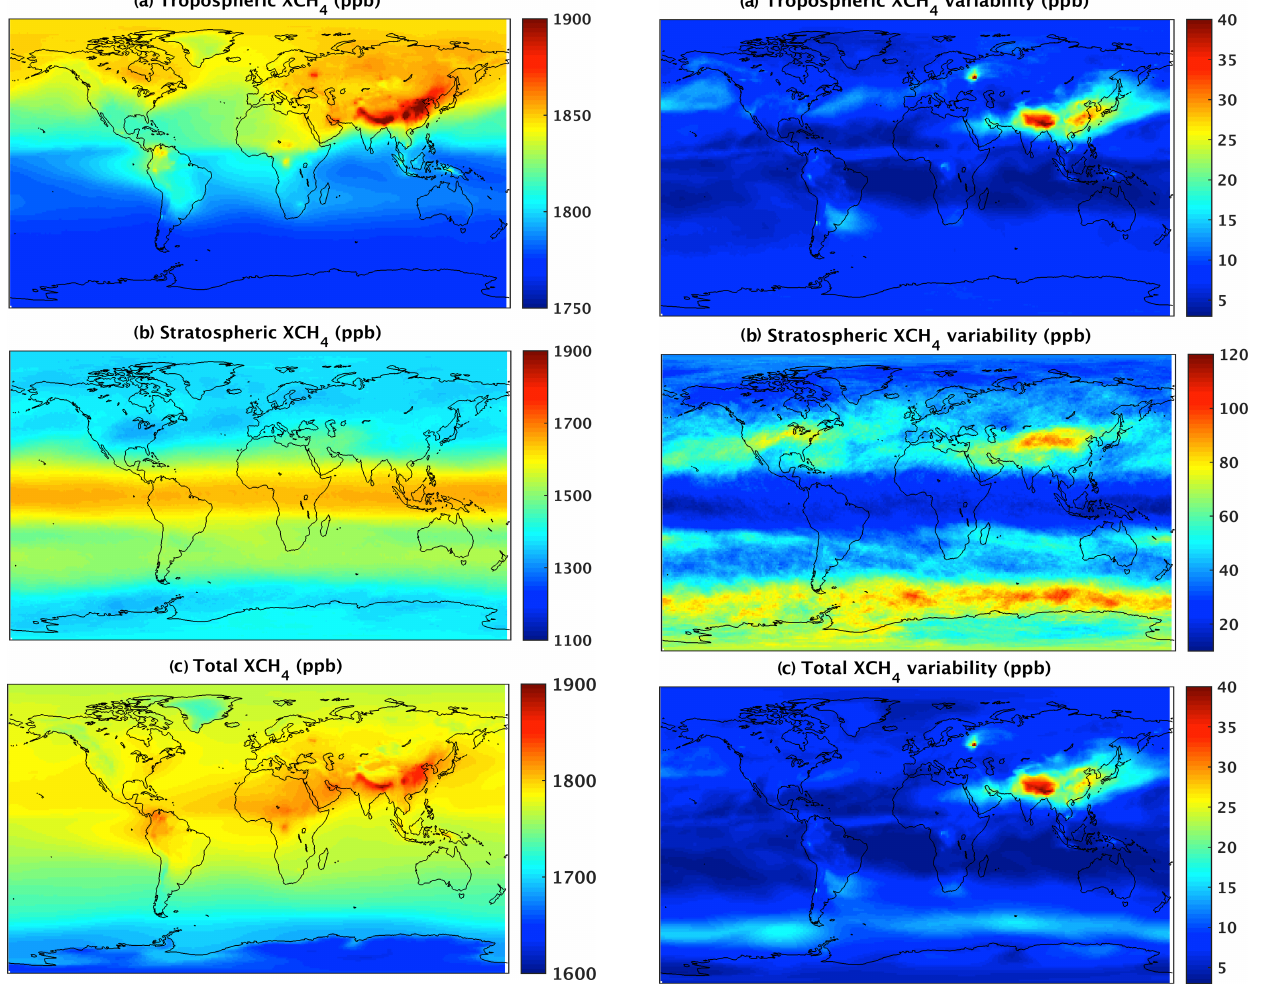
Figure 2. Variability (standard deviation) in the column abundance of CH 4 (in ppb) during June–August 2010 obtained from the C-IFS model fields for (a) tropospheric partial column, (b) stratospheric partial column and (c) total column. Note the different colour scales in the three